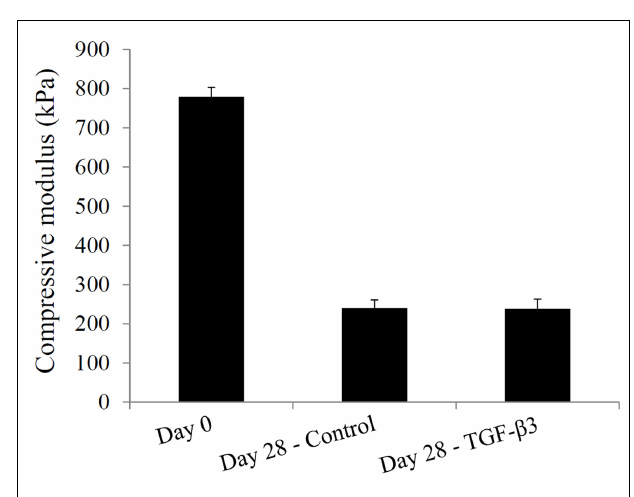
FIGURE 8 | Compressive moduli of hASC-encapsulated VL-PSL-fabricated constructs measured at culture days 0 and 28 in the control and TGF- β 3 groups